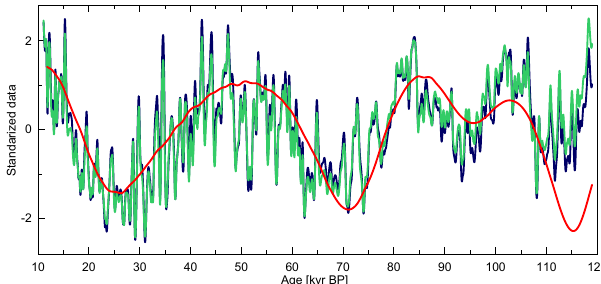
Figure 5. Red: the standardized 75.1 ◦ N integrated summer insola- tion sISI on days with more than 390Wm − 2 , splined with a 3kyr cutoff period. Blue: a standardized spline with a 750-year cutoff of the TAC ∗ record. Green: analogous to Raynaud et al. (2007) the TAC ∗ data after correcting for the temperature effect on pore vol- ume V cr (Martinerie et al., 1992). Note that the ice core data are given on the glaciological AICC2012 ice age scale (as solar insola- tion acts on the snow matrix and therefore on changes in TAC on the ice age scale), while ISI is on the absolute astronomical age